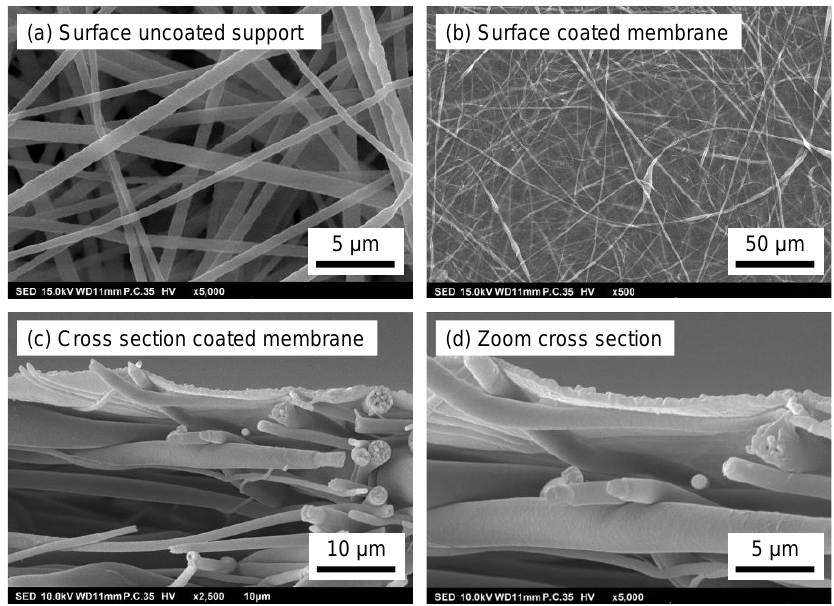
Figure 5. SEM images of the surface of ( a ) the uncoated electrospun PSU support; ( b ) the PA coated PSU support; and ( c , d ) the cross-section of the PA-coated PSU support.